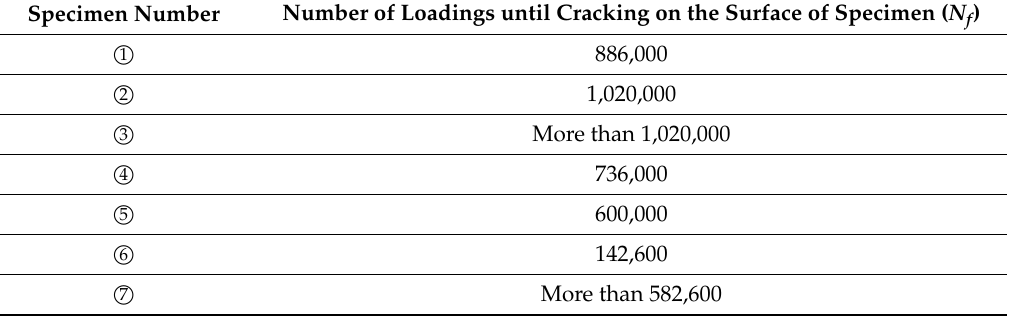
Table 3. The number of loadings to failure for each